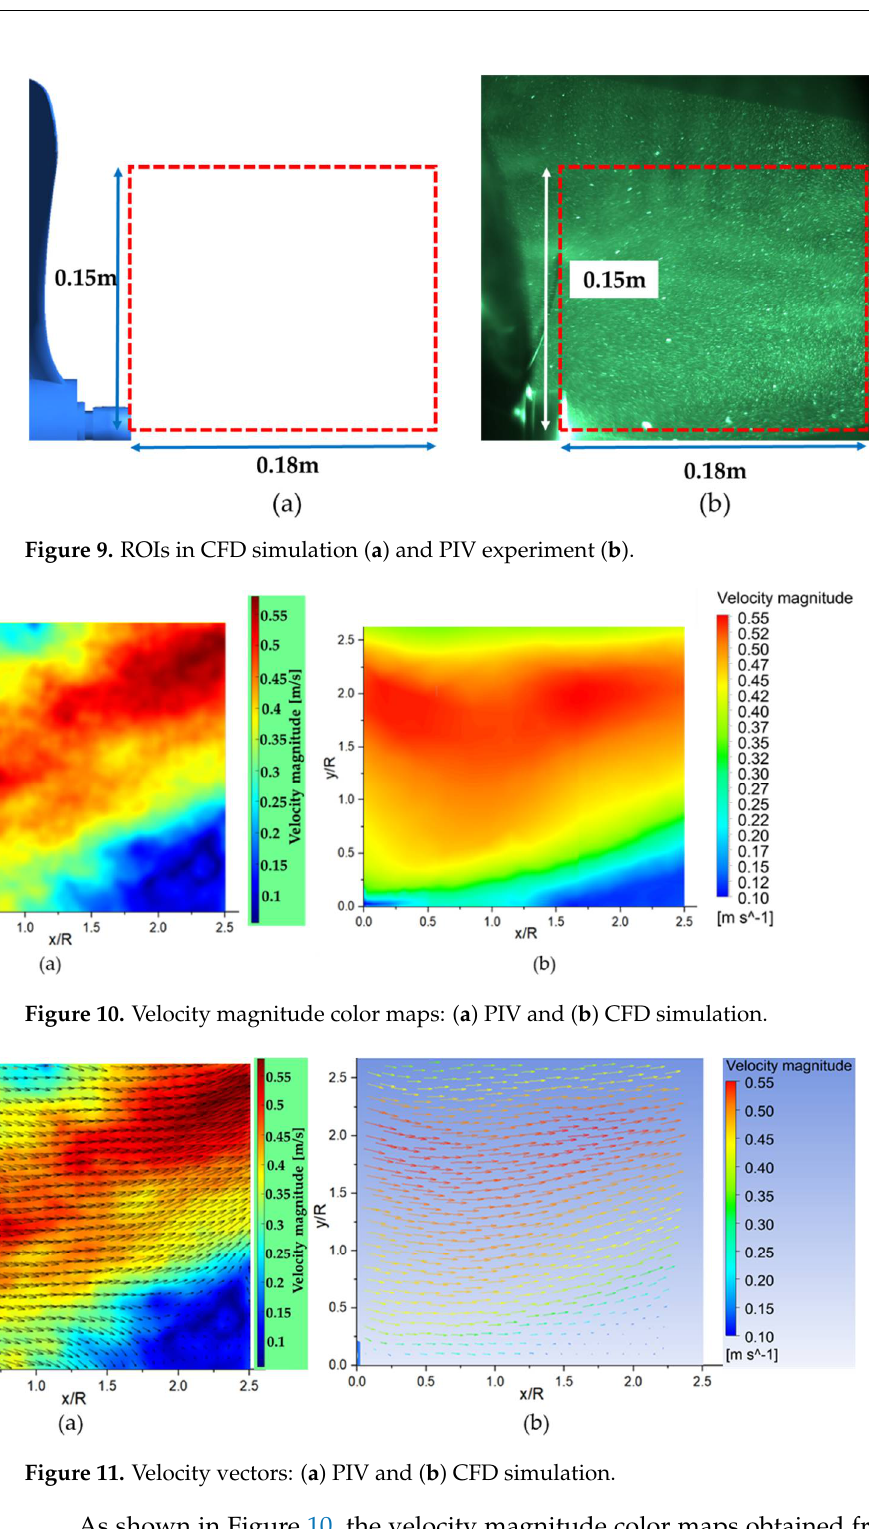
Figure 12. Velocity magnitude along ( a ) y/R=1.25 and ( b ) x/R = 1.25 in the ROI. As shown in Figure 10, the velocity magnitude color maps obtained from the CFD simulation showed a similar distribution pattern to the PIV experiment. The color maps showed low velocities distributing along the propeller hub axis in both the PIV experi- ment and the CFD simulation. The velocity magnitude distribution color contours were almost the same in both the CFD simulation and the PIV experiment. From Figure 11, the analysis of velocity vectors also showed a similar flow trend in both the CFD simulation and PIV experiment. The deviation in the velocity magnitude along the vertical and hori- zontal axes are as shown in Figure 12a,b, respectively. The maximum deviation in the velocity magnitude along y/R = 1.25 occurred at 0.072 m away from the propeller. Mean- while, maximum deviation along x/R = 1.25 occurred at 0.16 m along the propeller radius. The highest deviations attained were 4.815% and 4.019% along y/R = 1.25 and x/R = 1.25, respectively. The differences in velocity magnitude between PIV and CFD results along the x and y axes were small. Considering good agreement attained, the CFD models are suitable for modelling the effect of the rope cutter on the water flow behind the propeller. The validated CFD models were then utilized to model the water flow through the pro- peller and rope cutter in the remaining simulation cases, which are presented in detail in Section 2.5. 2.5. Step 4—Investigation of the Effect of Rope Cutter on the Flow behind the Propeller 2.5.1. Simulation Cases Six simulation cases were performed for a propeller rotating at 100, 150, and 200 rpm with and without a rope cutter, as shown in Table 4. In the table, 100 WRC, 150 WRC, and